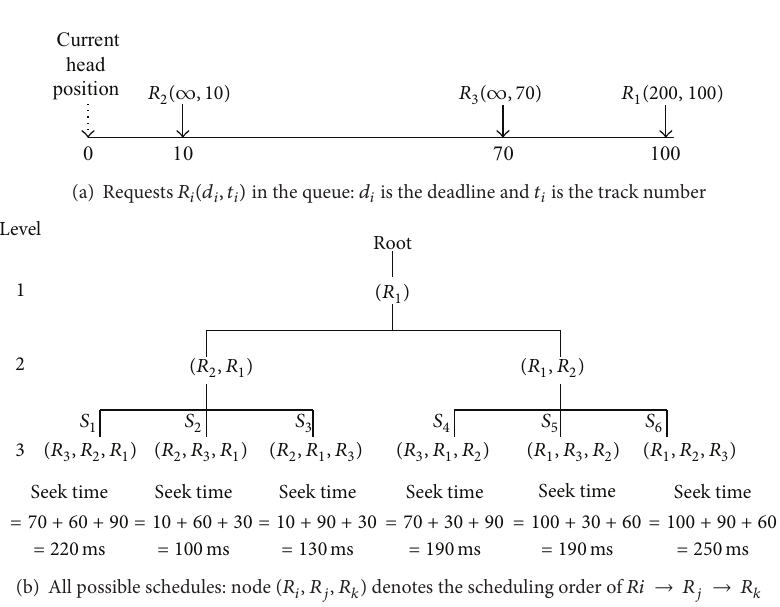
Figure 1: An example of grouping best-effort requests located closely to each other. In (a), the number of all possible combinations before grouping is 11 factorial . On the other hand, as in (b), the number of all possible combinations after grouping becomes 6 factorial .